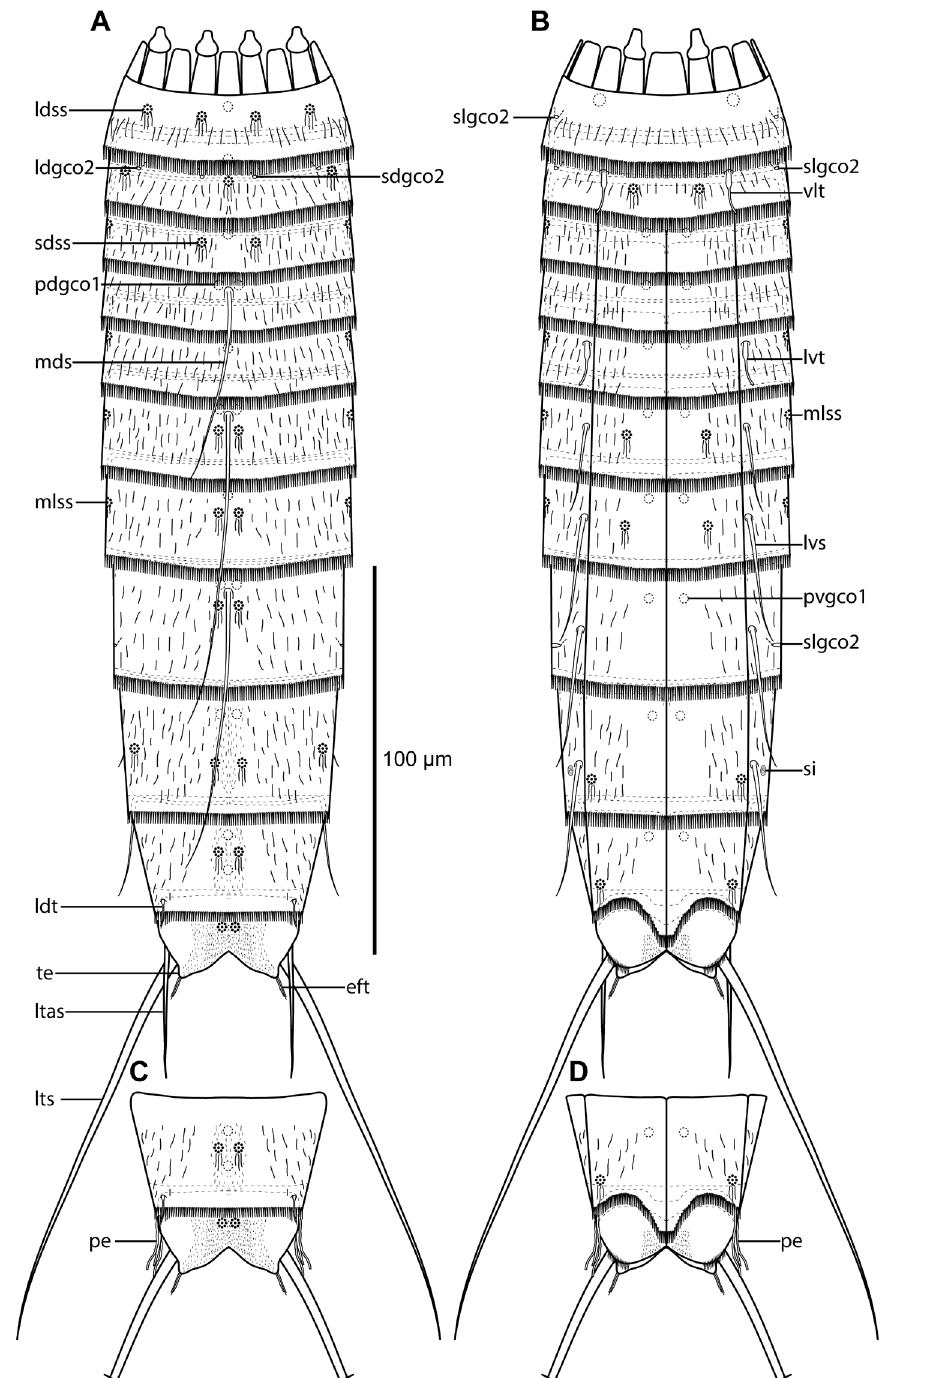
Fig. 7. Line art illustrations of Echinoderes hamiltonorum sp. nov. A . ♀, dorsal view. B . ♀, ventral view. C . ♂, segments 10 to 11, dorsal view. D . ♂, segments 10 to 11, ventral view. Abbreviations: eft = extended fringe tips; ldgco2 = laterodorsal glandular cell outlet type 2; ldss = laterodorsal sensory spot; ldt = laterodorsal tube; ltas = lateral terminal accessory spine; lts = lateral terminal spine; lvs = lateroventral spine; lvt = lateroventral tube; mds = middorsal spine; mlss = midlateral sensory spot; pdgco1 = paradorsal glandular cell outlet type 1; pe = penile spines; pvgco1 = paraventral glandular cell outlet type 1; sdgco2 = subdorsal glandular cell outlet type 2; sdss = subdorsal sensory spot; si = sieve plate; slgco2 = sublateral glandular cell outlet type 2; te = tergal extensions; vlt = ventrolateral